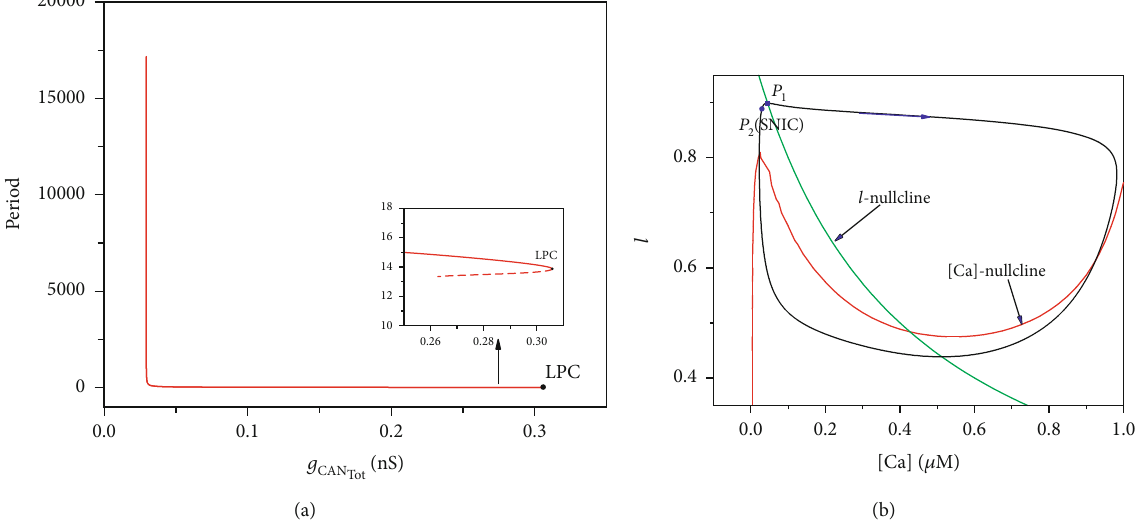
Figure 6: (a) The period of limit cycle of the fast subsystem with respect to parameter g subsystem (3a) and (3b). The red curve is the [Ca]-nullcline, and the green curve is l -nullcline. The black closed orbit is the solution of subsystem (3a) and (3b) projected in ( ½ Ca (cid:2) , l